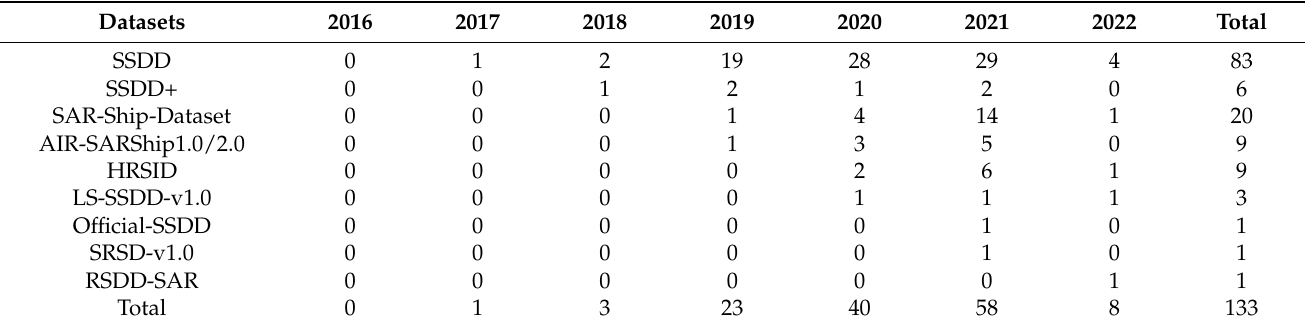
Table 2. The datasets that are used in the past five